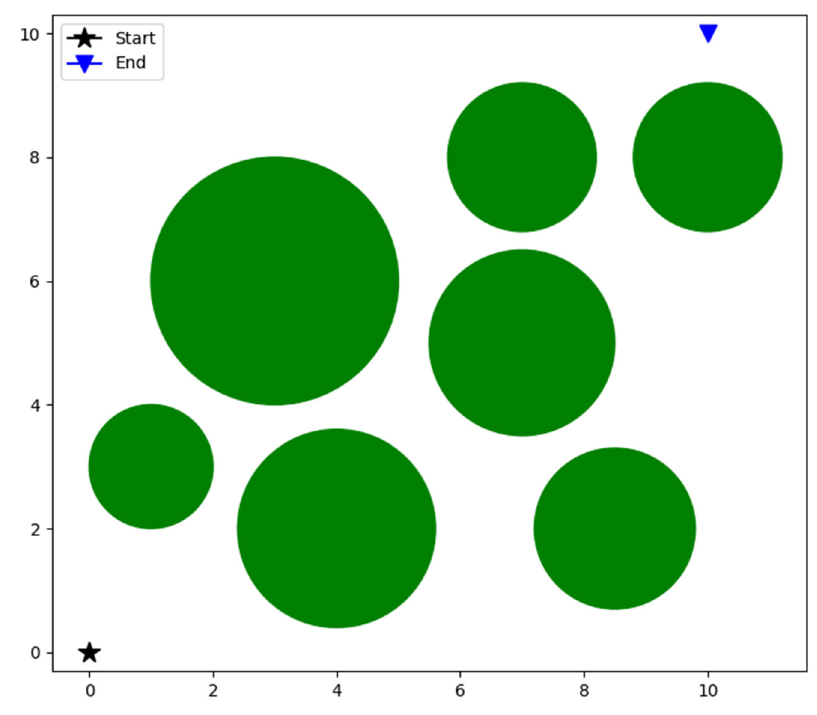
Figure 35. Environment modeling.